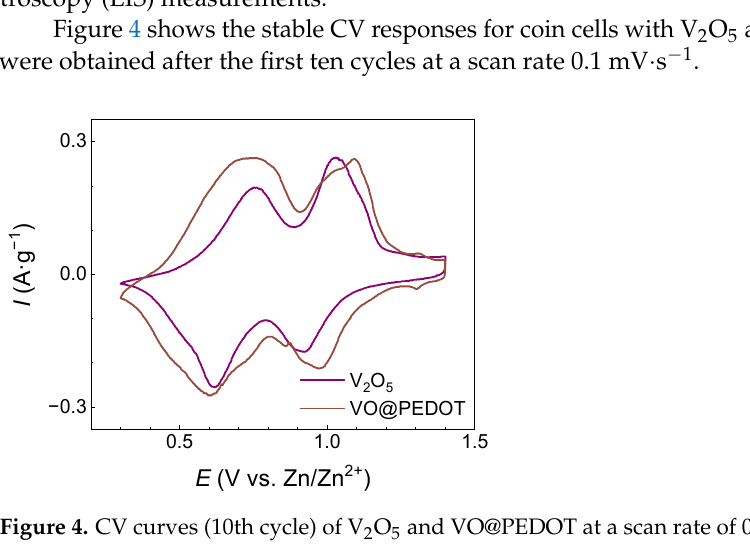
2 O 5 and VO@PEDOT at a scan rate of 0.1 mV